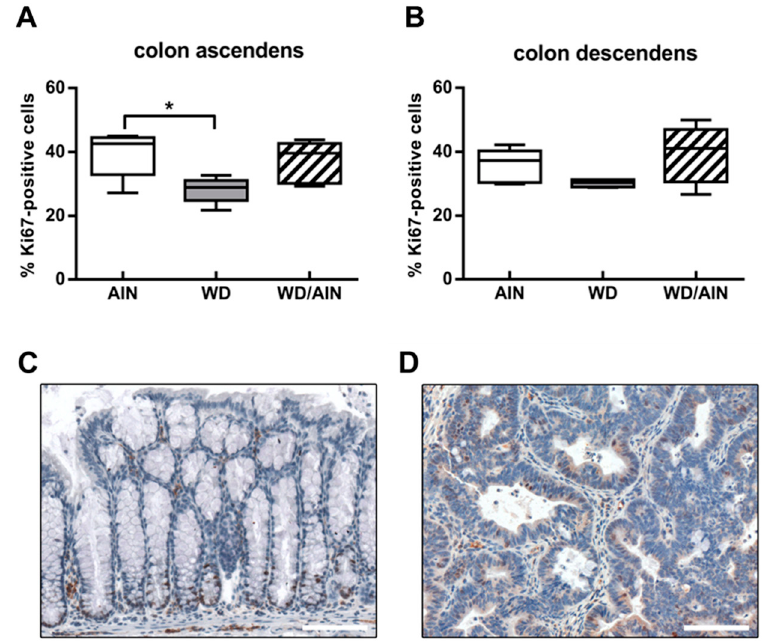
Figure 7. E ff ect of the diet on proliferation of colonic crypts. Ki67-positive cells in untransformed crypts of ( A ) colon ascendens and ( B ) descendens. For each animal, three regions consisting of two to five crypts were chosen and the total number of Ki67-positive and of Ki67-negative cells were determined. n = 4–6; median, interquartile range, and whiskers (min to max); in the WD group of ( A ) one outlier, as determined by Grubbs’ test, was excluded from analysis; and ANOVA with Tukey post-hoc test, * p < 0.05. Representative pictures of Ki67 (brown) staining ( C ) in the untransformed mucosa of the WD / AIN group and ( D ) in a tumor of the WD group. Color and contrast of the images ( C , D ) were non-linearly enhanced for purpose of presentation only, scale bars = 100 µM.